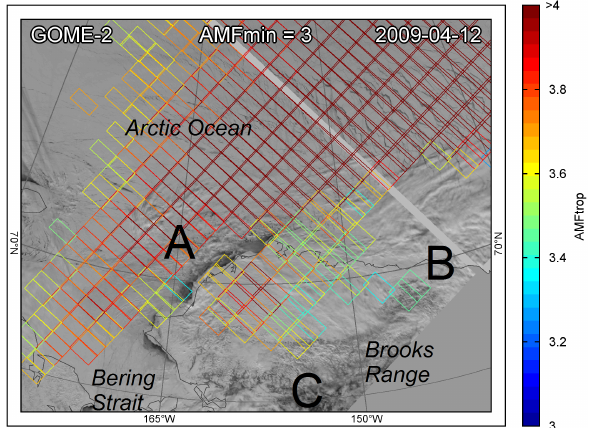
Fig. 11. Overlying image of derived A 500 (colour-coded) and AVHRR reflectance measurements (monochrome background, channel 1, 630nm) over Northern Alaska and the Arctic Ocean. Blue quadrangles indicate GOME-2 satellite pixels with an assured sensitivity to near-surface absorbers ( A 500 ≥ 3). Pixels above leads at the north-west coast of Alaska (A), above clouds (B), and over the dark Brooks Range (C) are labelled possibly obscured ( A 500 < 3) and not